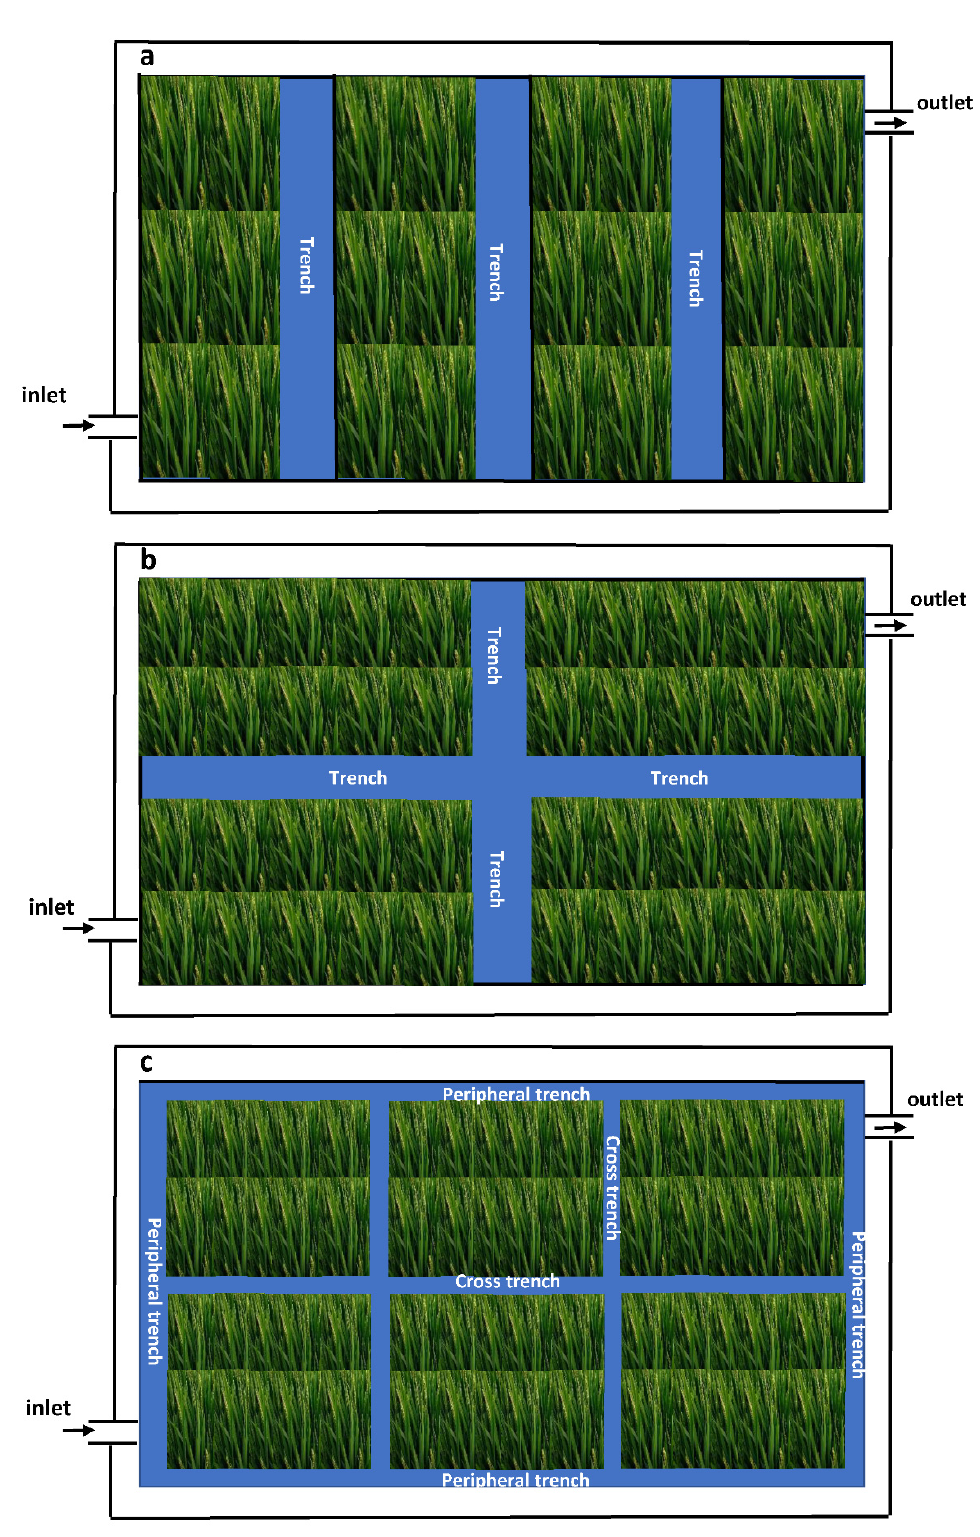
Figure 3. The evolution of trench designs in the rice–crab coculture system: ( a ) line-shaped trenches; ( b ) cross-shaped trenches; ( c ) and circular-shaped trenches.